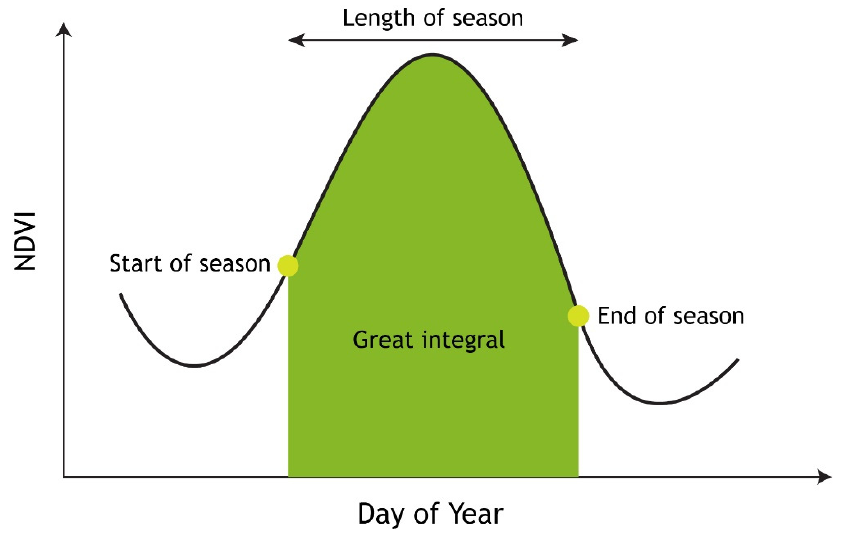
Figure 3. Phenological metrics illustration from the NDVI profile for one cropping season. Table 1. Input setting for NDVI time series processing in TIMESAT used in this study, as recom- mended by [52].